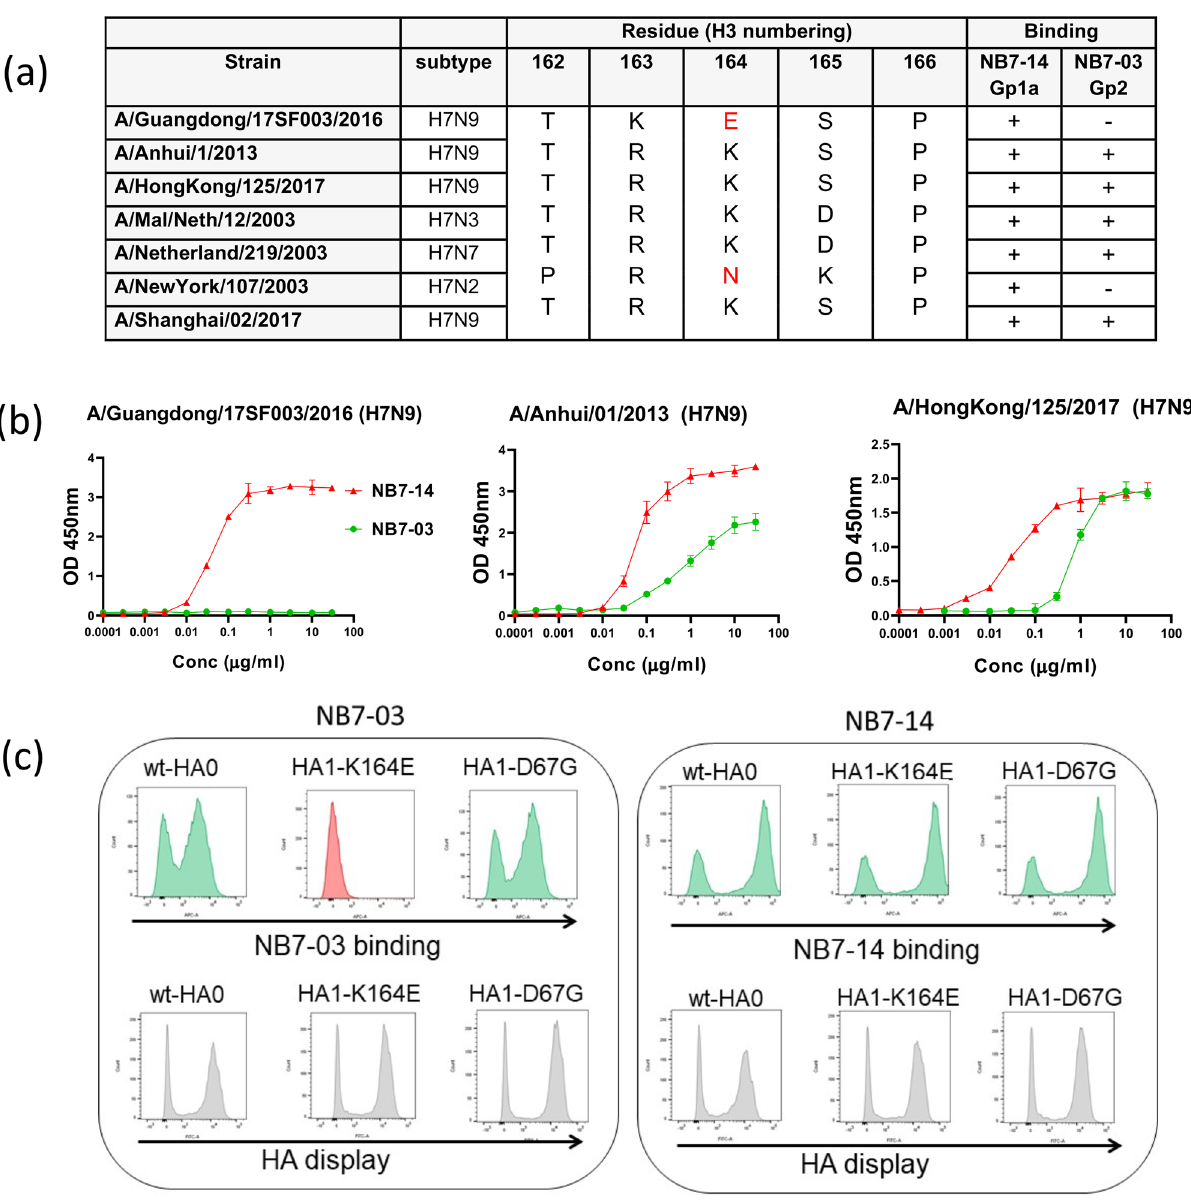
Figure 6. Correlation of epitope Gp2 specificity to natural sequence divergence. ( a ) Correlation of binding of NB7-03 (Gp3) and NB7-14 (Gp1a) to natural sequence divergence at K164. ( b ) ELISA of purified NB7- 14 (red) and NB7-03 (green) binding to inactivated whole virus antigen preparations from the following: A/ Guangdong/17SF003/2016 (H7N9); A/Anhui/01/2013 (H7N9) and A/Hong Kong/125/2017 (H7N9). ( c ) Confirmation of specificity of NB7-03 and NB7-14 to yeast cells displaying the HA1-K164E